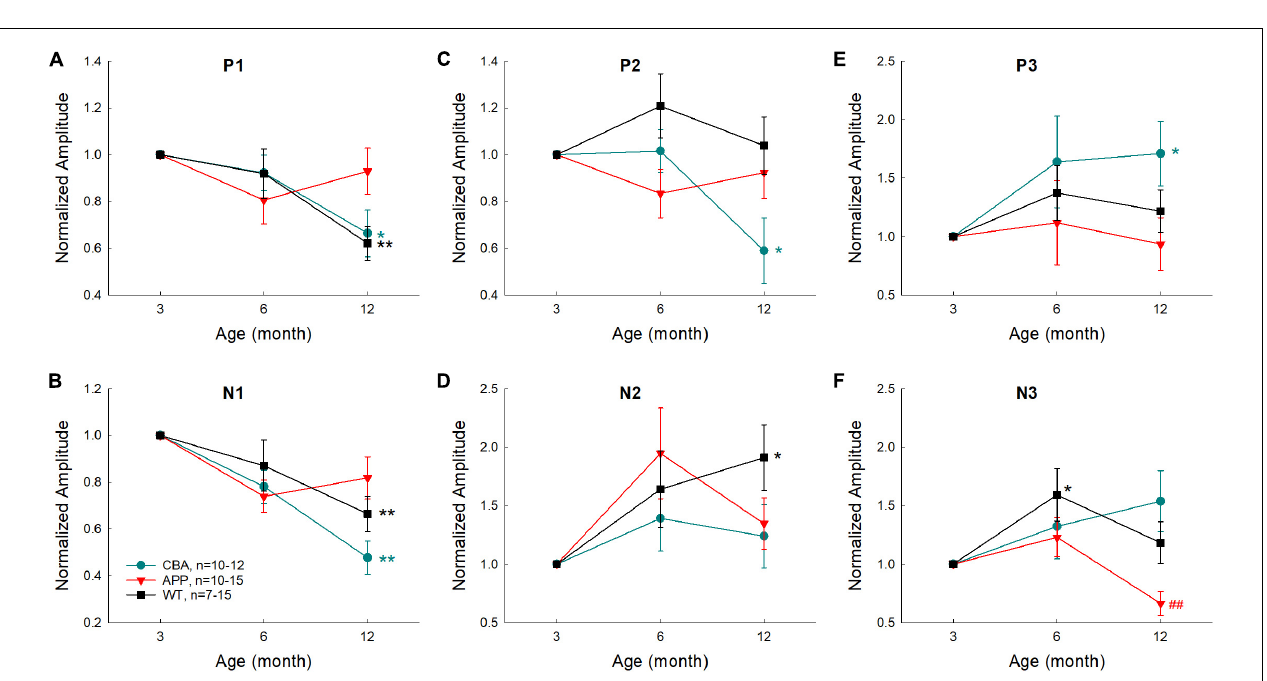
FIGURE 7 | Effects of aging on AECP in CBA/CaJ, APP/PS1 AD, and WT littermate mice. The amplitudes of peaks were normalized to those at 3 months old in each group. Peak name is presented at the top middle place in each panel. N is the animal number. The statistical t -test with two-tailed was performed by comparing data at 3 months or data at 6 months within each group. Early AECP peaks (P1, N1, and P2) in CBA mice and WT littermates are decreased as age increased, while later peaks (N2, P3, and N3) are increased or not changed with aging. However, AD mice have no significant changes in AECP peaks with aging except peak N3 at 12 months old, which is decreased. * p < 0.05, ** p < 0.01, t -test, two-tailed, vs. 3 months; ## p < 0.01, t -test, two-tailed, vs. 6 months.